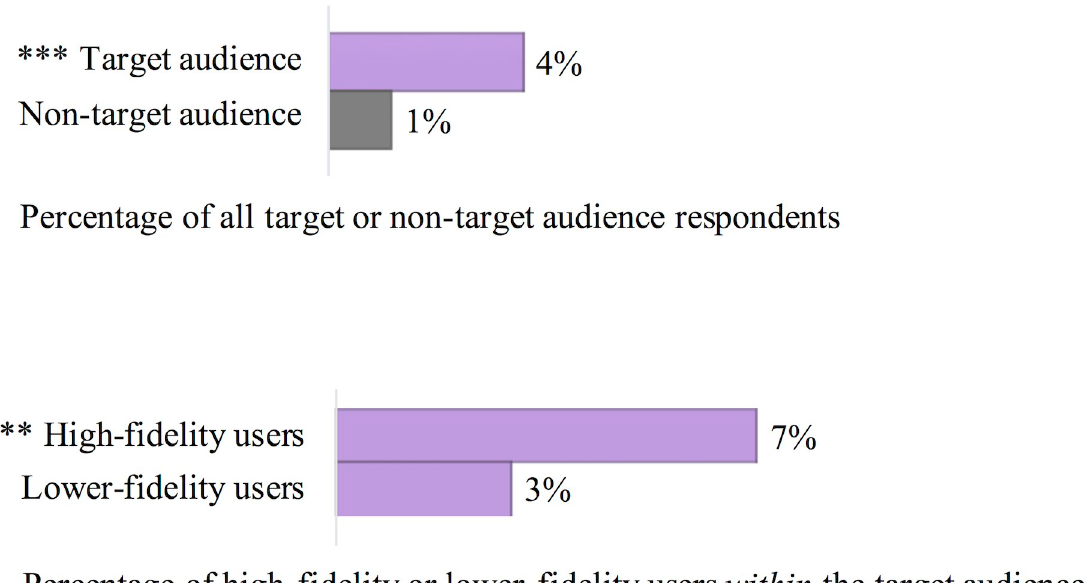
Fig 4. Stated decrease in saiga horn usage following the intervention for those with accurate intervention recall. Percentages of the top graph are out of the target or non-target audience respondents (438 and 1,678 people respectively). Percentages of the lower graph are out of high-fidelity and lower-fidelity users within the target audience (99 and 339 people respectively). Asterisks indicate the target audience and high-fidelity users within this audience were significantly more likely to state a behaviour change ( �� for p-value < 0.01, and ��� for p-value <